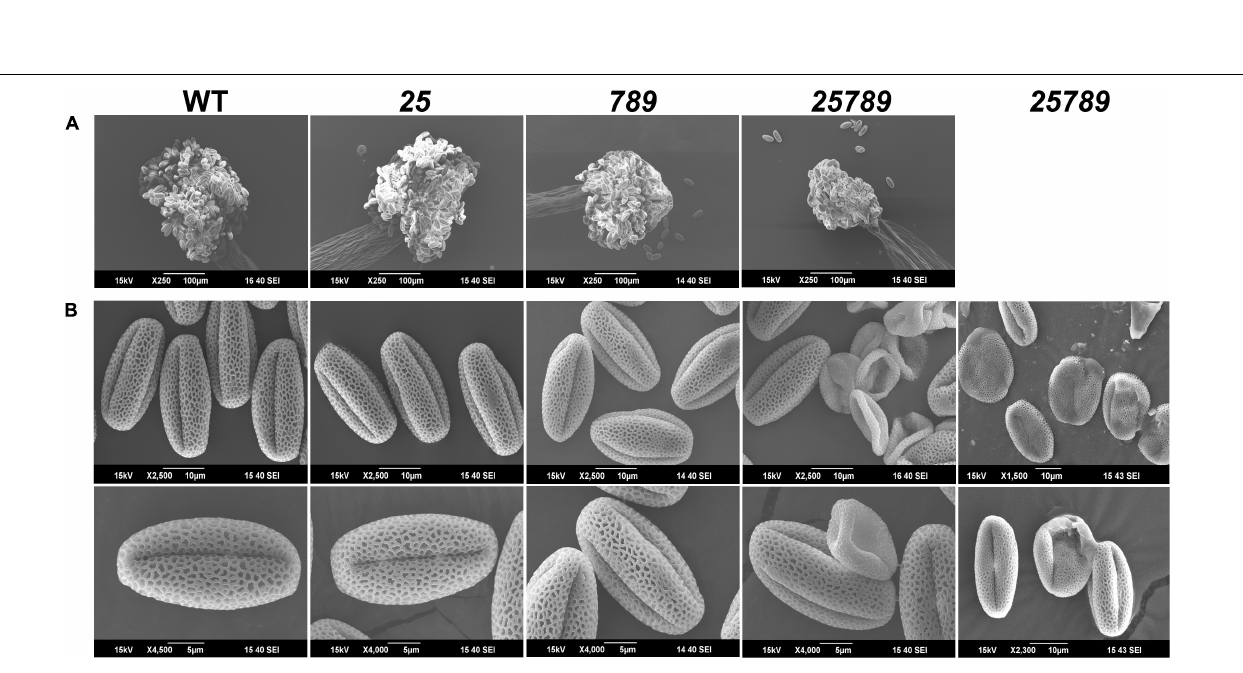
Frontiers in Plant Science |